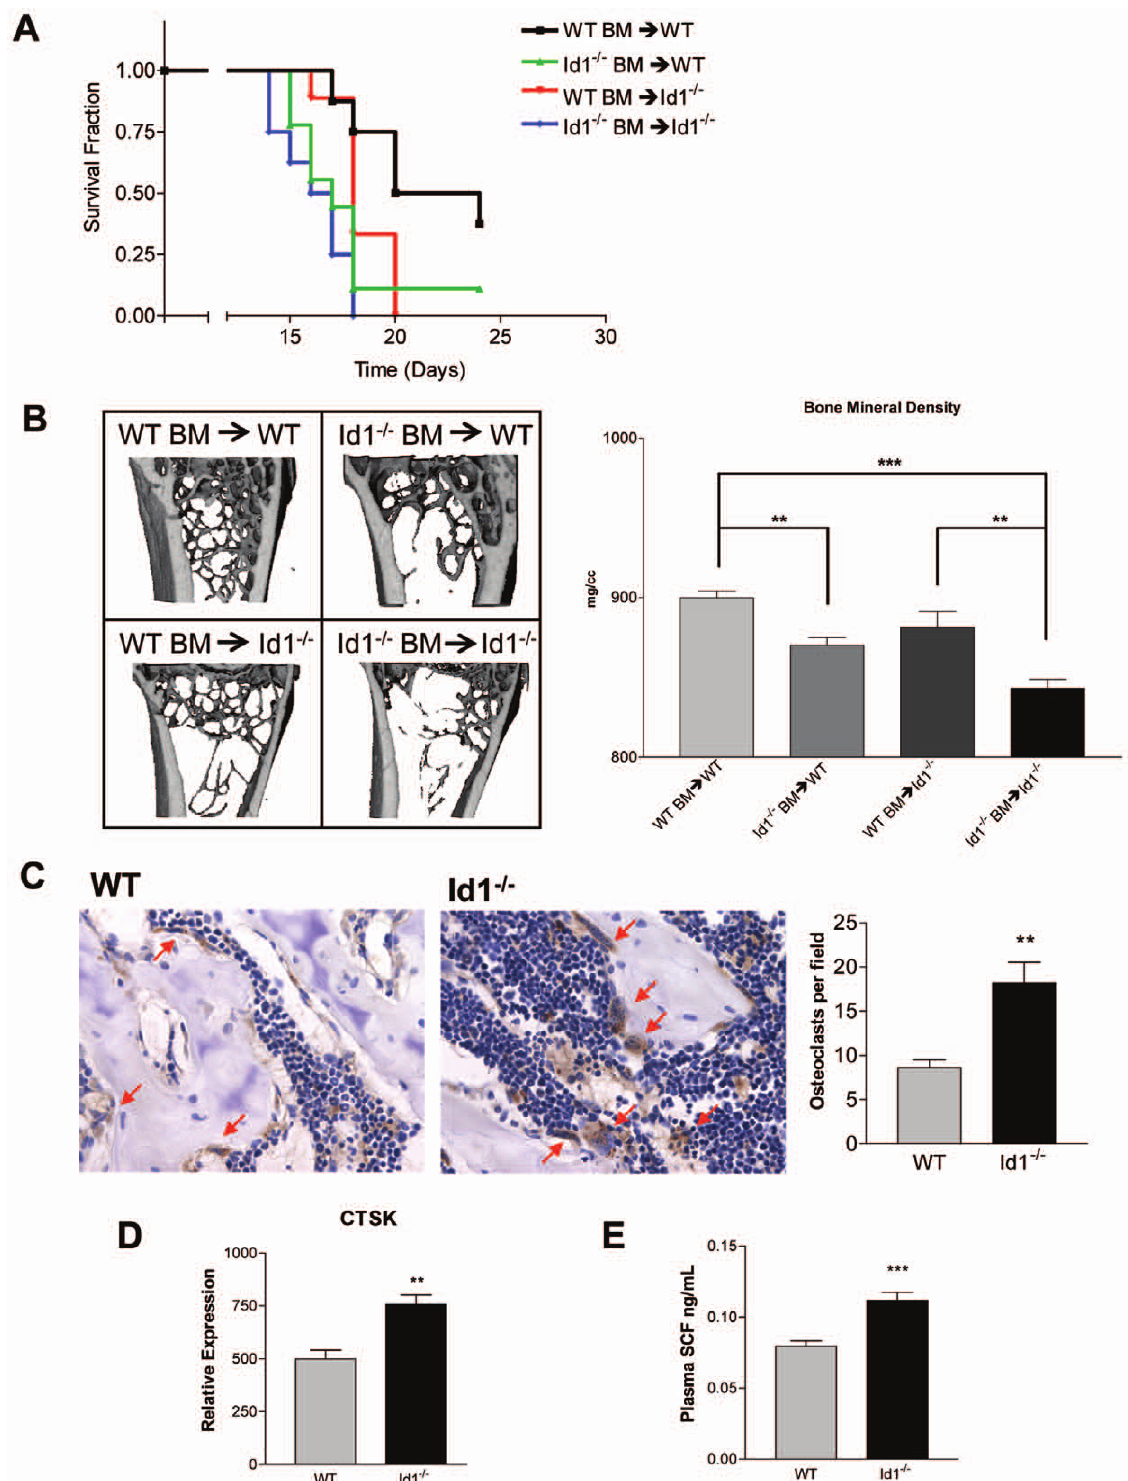
Figure 5. Loss of Id1 alters extrinsic niche factors. (A) Survival over time of BM transplanted mice treated with weekly injections of 5-FU. Lethally irradiated wild-type and Id1 2 / 2 mice were transplanted with either wild-type or Id1 2 / 2 BM. After 6 weeks to allow for hematopoietic reconstitution, the mice were injected weekly with 5-FU and their survival was monitored (n=10). (B) Representative micro-CT images of the femoral distal trabecular region and bone mineral density measurements in BM transplanted mice (**P , 0.01, ***P , 0.001; n=5). (C) CTSK staining of femoral sections (400X). Arrowheads indicate CTSK + osteoclasts stained in brown (**P , 0.01; n=5). (D) Level of expression of CTSK in the BM of wild-type and Id1 2 / 2 mice (**P , 0.01; n=8). (E) SCF levels in plasma assayed by ELISA (***P , 0.001; n=8). Error bars represent 6 S.E.M.